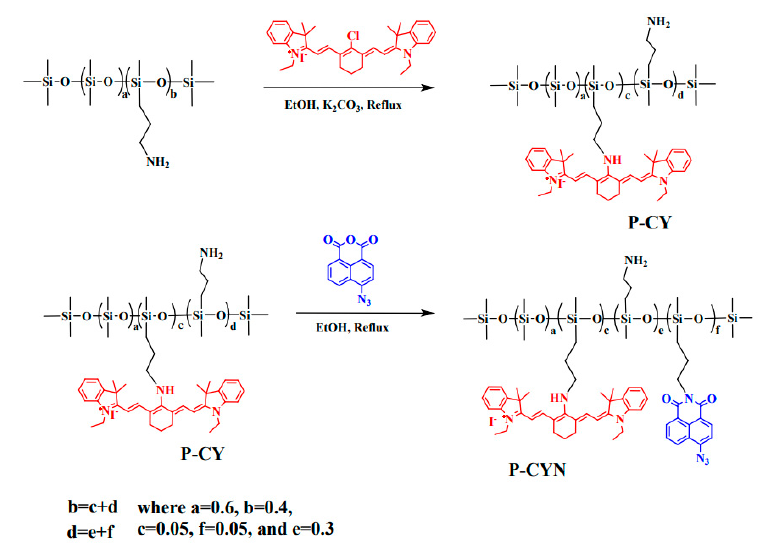
Figure 15. The preparation process of a fluorescent polysiloxane (P-CYN) with a dual fluorescent mode [96]. Copyright 2020, Royal Society of Chemistry.